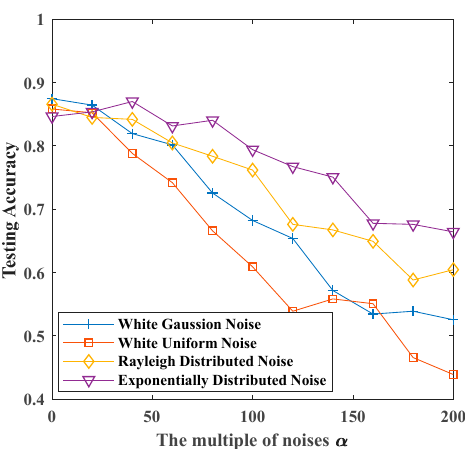
Figure 11. The maximum testing accuracy of original SCN with different noises.